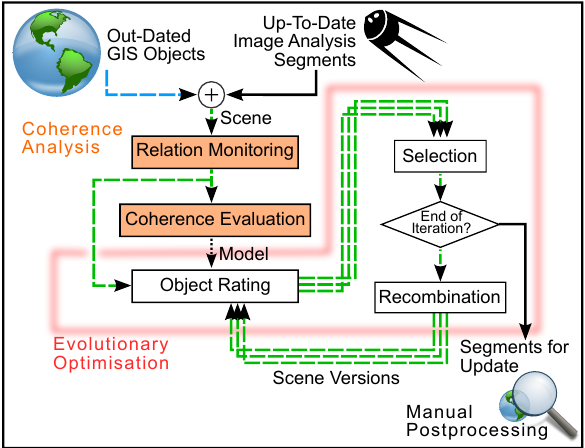
Figure 2: Object Coherence Analysis and Update Detection by Evolutionary